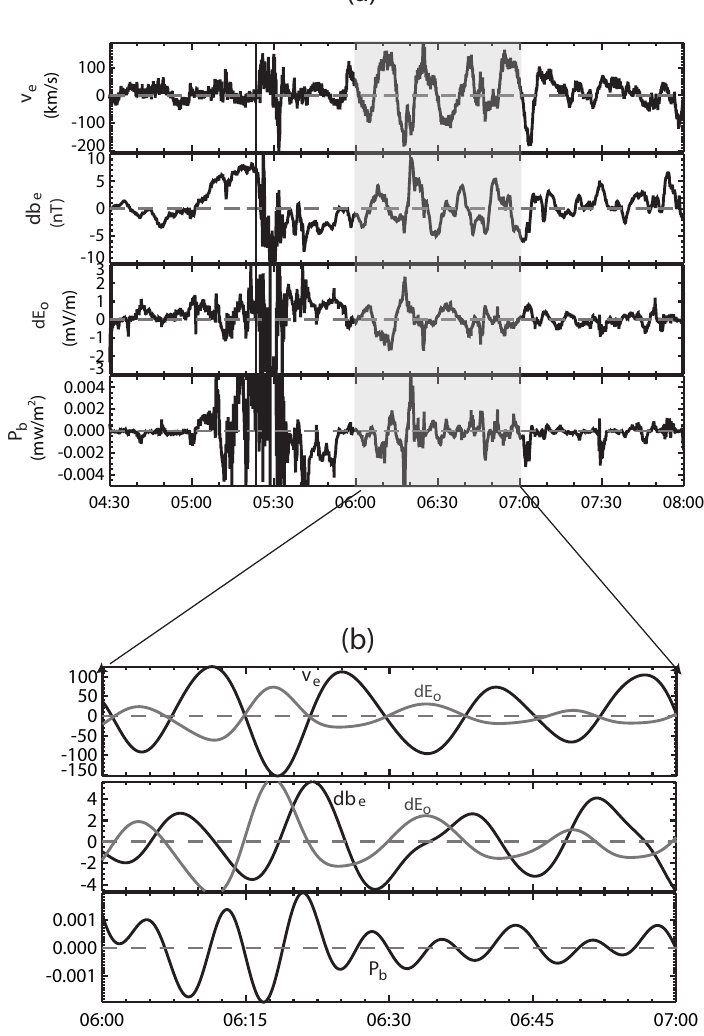
Fig. 4. Parameters of oscillations seen on 8 August 2003 by Cluster 3 in magnetic field-aligned coordinates (see text for details) with (a) showing the unfiltered data and (b) showing an expanded view of the event with a band-pass filter [0.4mHz, 2.5mHz]